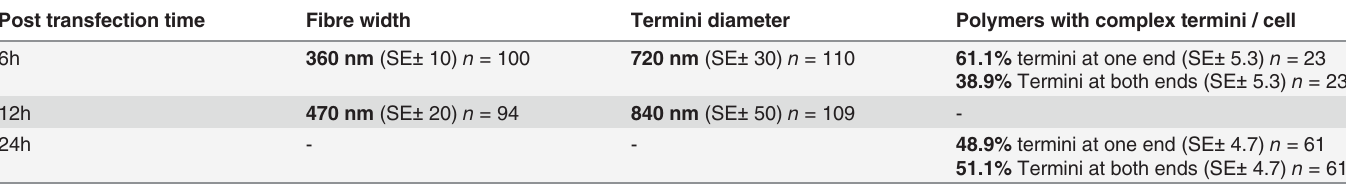
Table 1. Mean termini diameter, fi bre width, and termini formation of untagged BILBO1 after expression in U-2 OS cells. Post transfection